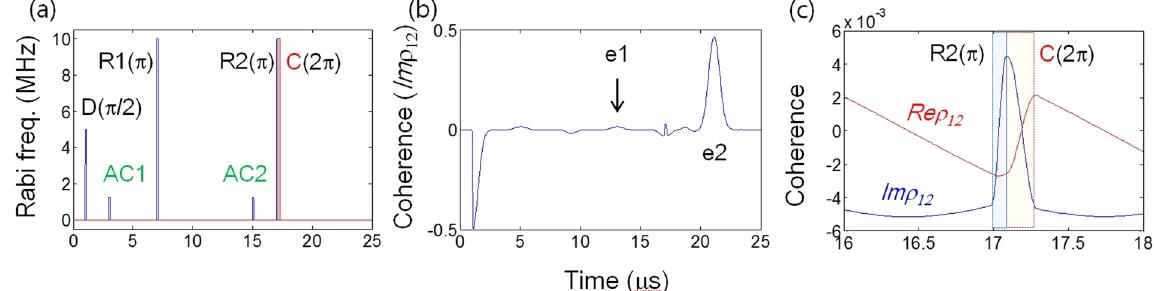
Figure 4. Controlled ac Stark echoes (CASE). ( a ) Pulse sequence: Data D, Rephasing R1, Rephasing R2, ac Stark pulses AC1 & AC2, and control pulse C. ( b ) and ( c ) Numerical results of ( a ). The arrival time of C is 17.1 μ s with 0.2 μ s pulse duration. All parameters are the same as in Fig. 3, unless otherwise specified.